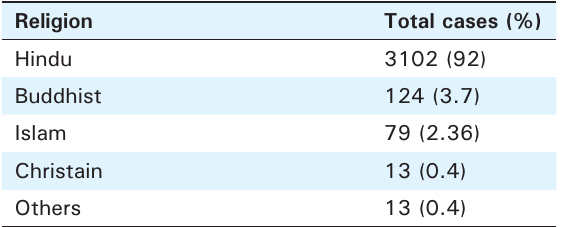
Table 5. Top fi ve districts with cervical carcinoma